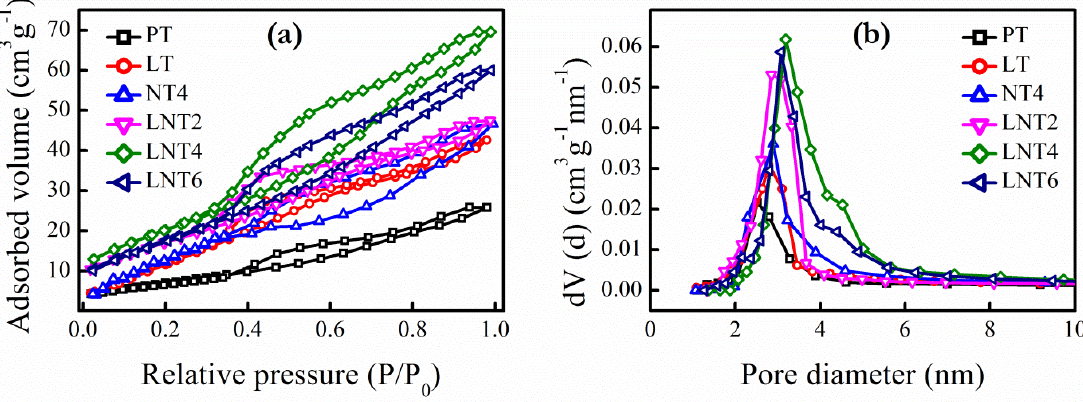
Figure 2. ( a ) N 2 adsorption-desorption isotherms and ( b ) pore diameter distribution curve of prepared NPs. Table 2. The pH IEP , BET surface area, BJH pore volume and pore diameter of all synthesized NPs.